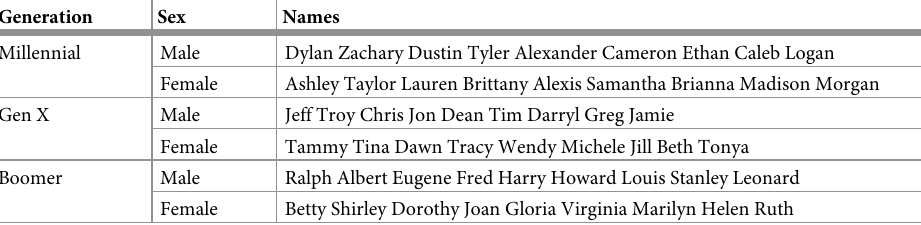
Table 1. Author first names. The nine manipulated author first names within each sex and age